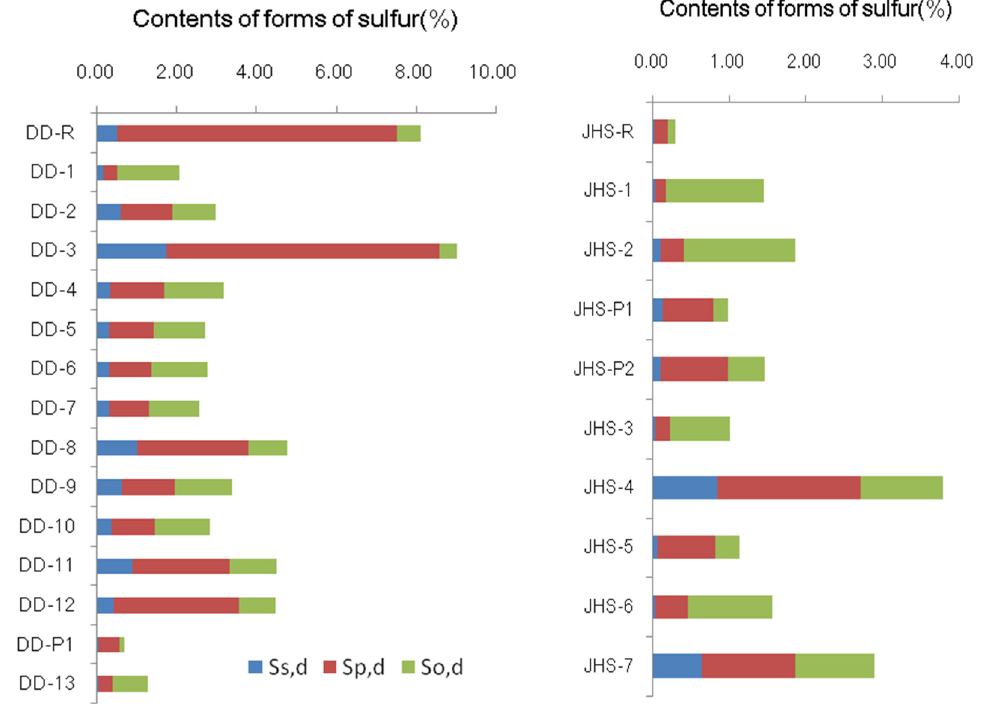
Figure 3. Variations of forms of sulfur through the studied coal seams.